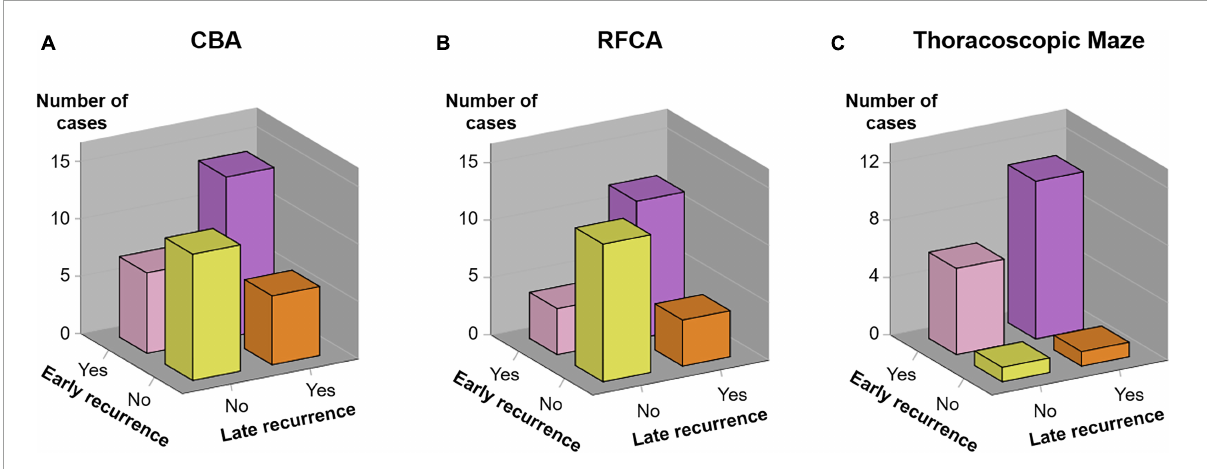
FIGURE2 Association between early and late recurrence. The incidence of early recurrence and late recurrence in each treatment group [ (A) CBA group, (B) RFCA group, and (C) Thoracoscopic Maze group] is demonstrated. CBA, cryoballoon ablation; RFCA, radiofrequency catheter